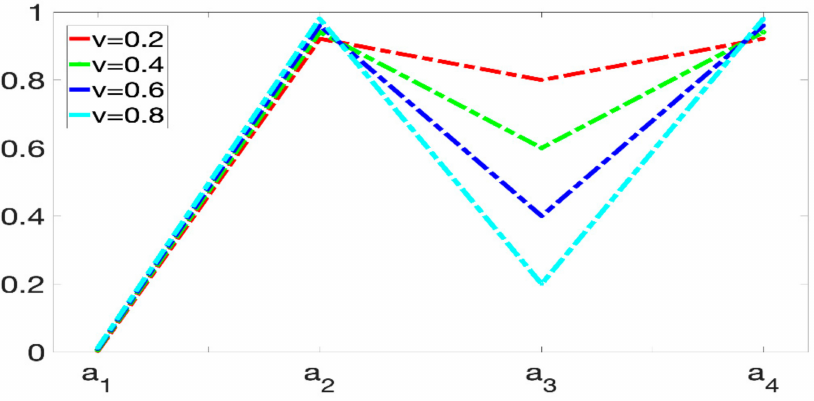
Figure 4. Sensitivity analysis of the ranking values of the expropriator’s